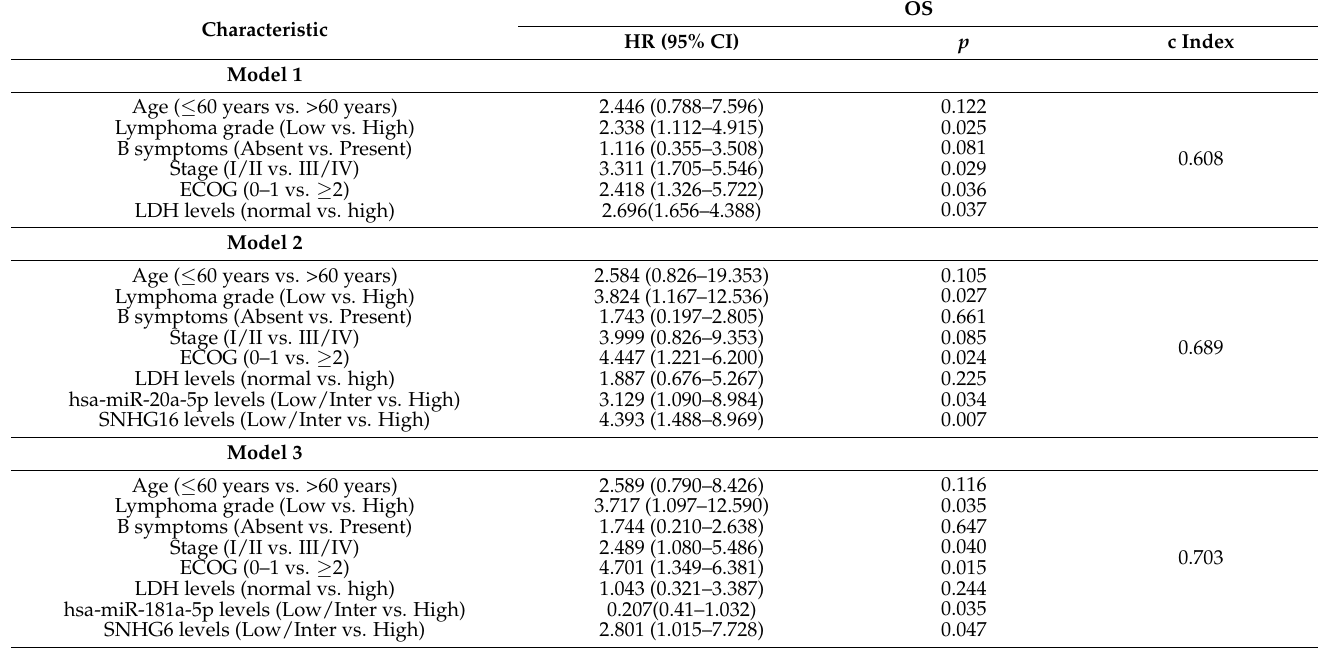
Table 5. The results of the multivariate analysis for overall survival regarding each ceRNA network pair.